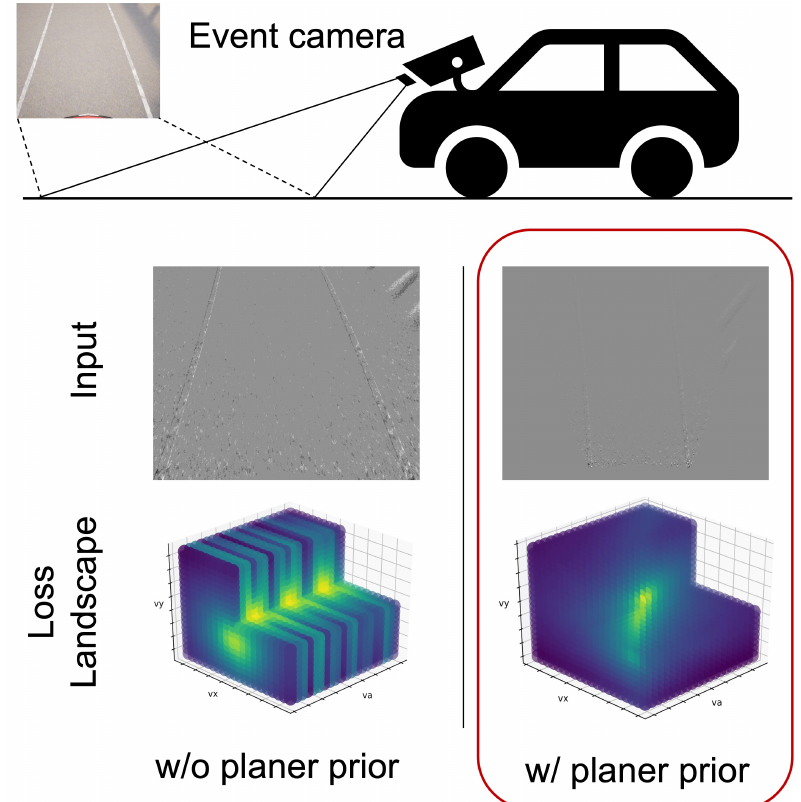
Figure 2. Overview of our method. When capturing a road surface at an angle for motion estimation, it can be difficult to track using an RGB camera. Even with an event camera, homographic motion estimation can have multiple extrema in the loss function. By performing a bird’s-eye view transfor- mation, the loss function becomes convex around the true value, which allows for improvements in accuracy and